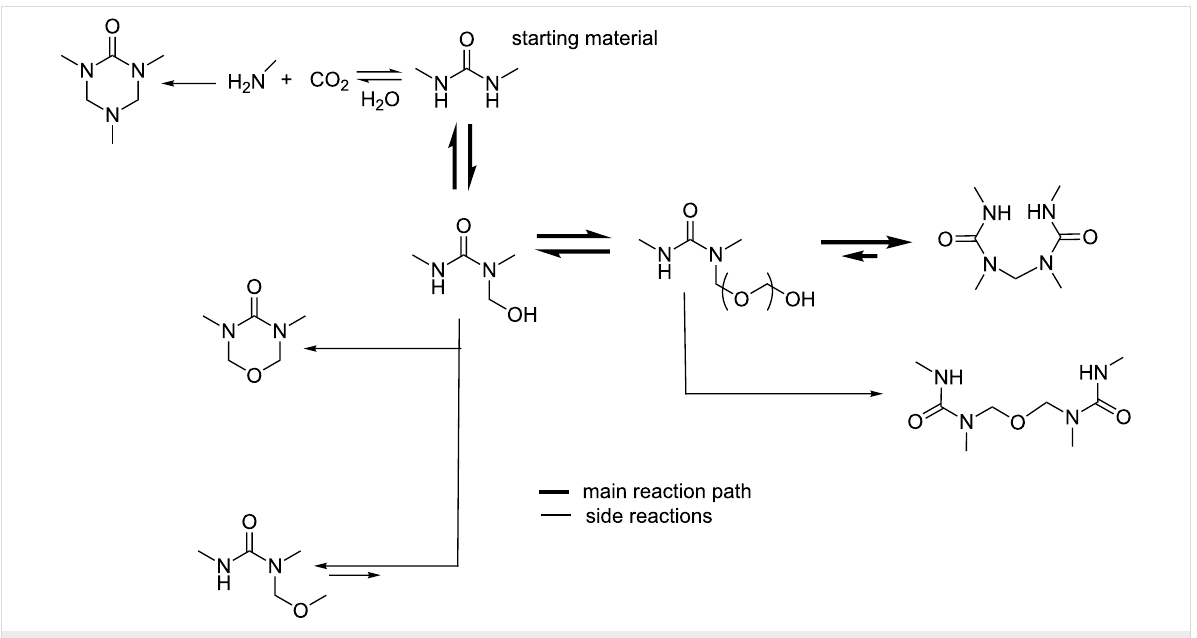
Figure 11: Reaction system 1,3-dimethylurea/formaldehyde. Main reaction pathway and side reactions [47].